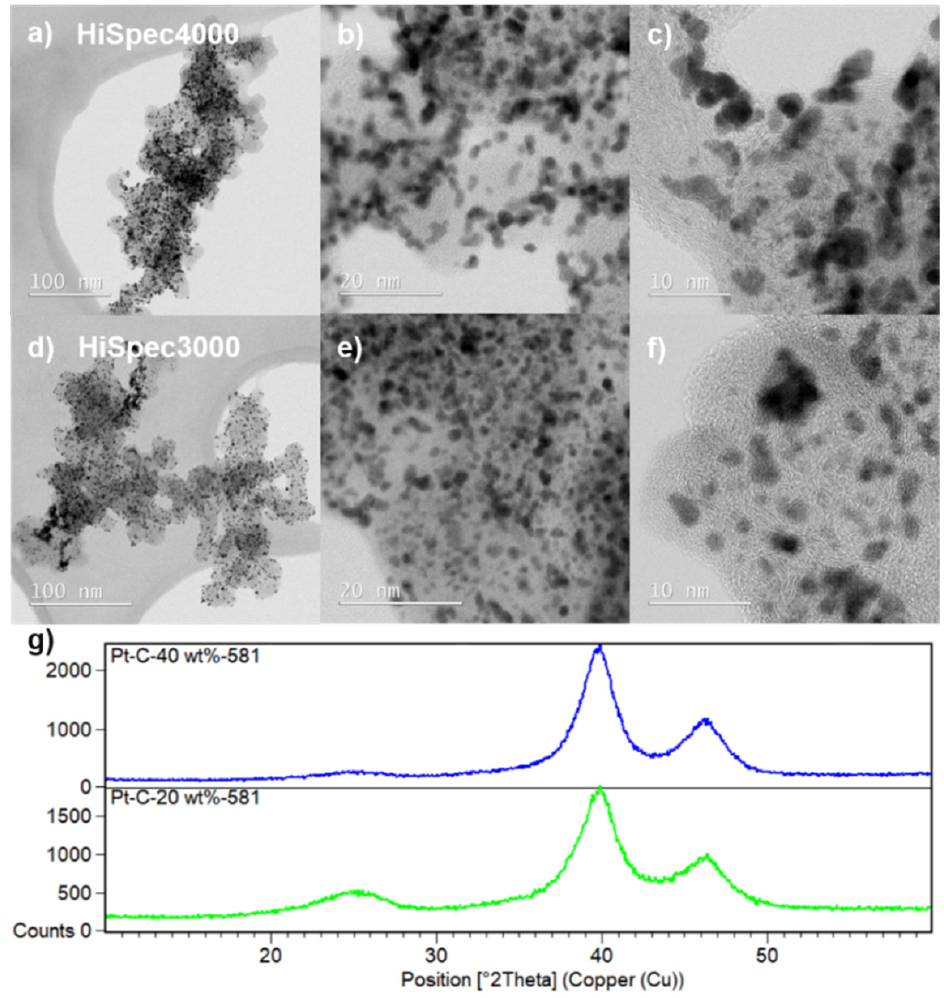
Figure 3. STEM BF images of Pt/C ( a – c ) HiSpec 3000 and ( d – f ) HiSpec 4000 at different magnifications and powder XRD spectra of the two catalysts ( g ). Samples were observed in unprocessed powder form. The XRD spectra show that platinum crystallite size is increasing in the following order: Hi-spec 3000 < Hi-spec 4000. According to the conclusions made by J. P. Owejan et al. [30] this should lead to slightly increased diffusion resistance at the same catalyst layer thickness for the MEA using HiSpec 4000. Additional factors influencing oxygen and proton transport in the catalyst layer are the I/C ratio and rheological properties of the ink used for the coating process [39,40]. Since the I/C ratio is slightly lower in the HiSpec 3000 catalyst layers, the porosity and ionomer distribution will inherently be different then in HiSpec 4000 catalyst layers. In summary, the resistance stemming from oxygen transport increases with decreasing platinum surface area under constant platinum loading and with the same ink composition of the coating process. Results of RDE-CV analysis can be seen in Figure 4. The values for mass activity, surface activity and ECSA are found in Table 3. These show very well that the catalysts have very similar specific (surface) activities, indicating that the particles have very similar crystal lattice structures at the surface. However, the much larger ECSA of HiSpec 3000, results in an almost doubled mass activity. This is the effect of the finer distribution of Pt on the carbon surface, leading to smaller